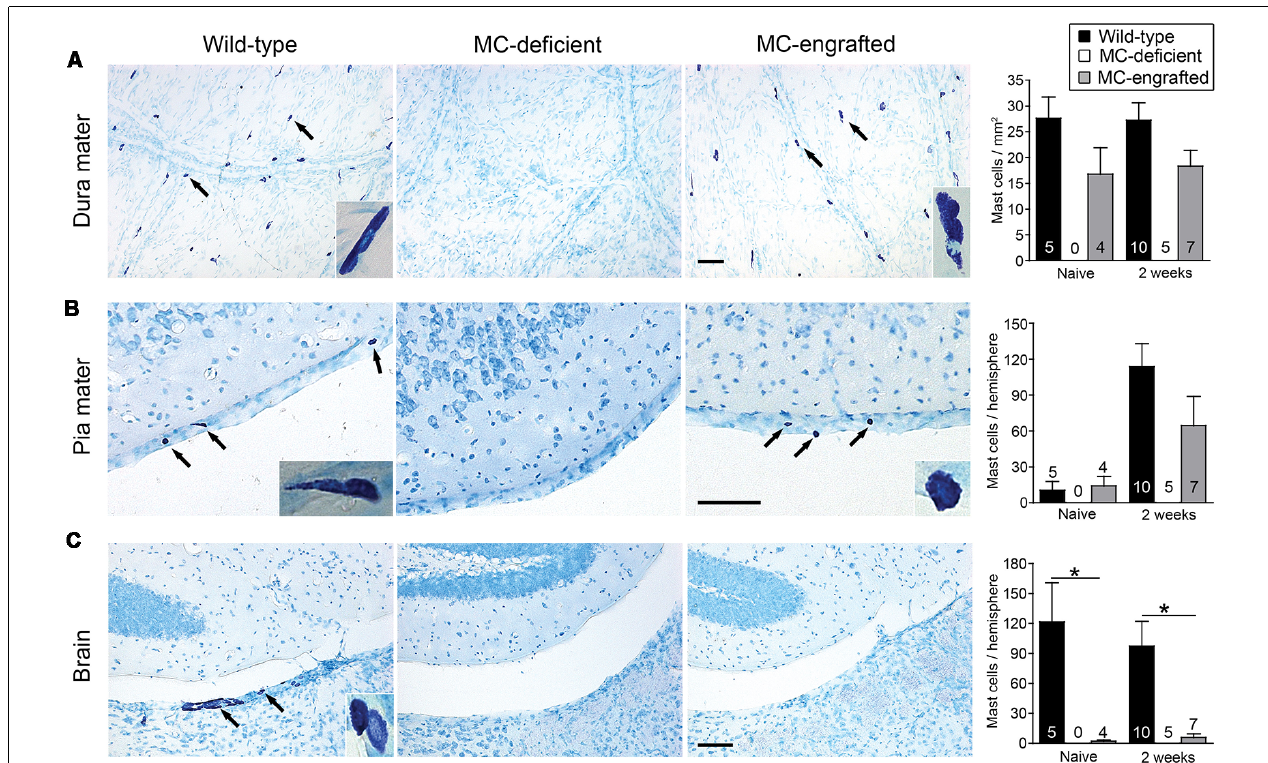
FIGURE 2 | Location of MCs in the central nervous system (CNS). Representative toluidine blue-stained images of and quantification of MCs in dura mater (A) , pia mater (B) , and brain parenchyma (C) of MC-deficient WBB6F1- Kit W / W-v mice and the corresponding wild type (WT) mice and MC-engrafted Kit W / W-v mice. MCs stain purple with toluidine blue; arrows indicate representative MCs. Insets show magnified images of MCs in each tissue. Data are expressed as means+SEM. The number of mice in each group is indicated in (or over) each bar. ∗ P < 0.05. Scale bars: 100 mm (A–C) . Reprinted from Arac et al. (2014) with permission from